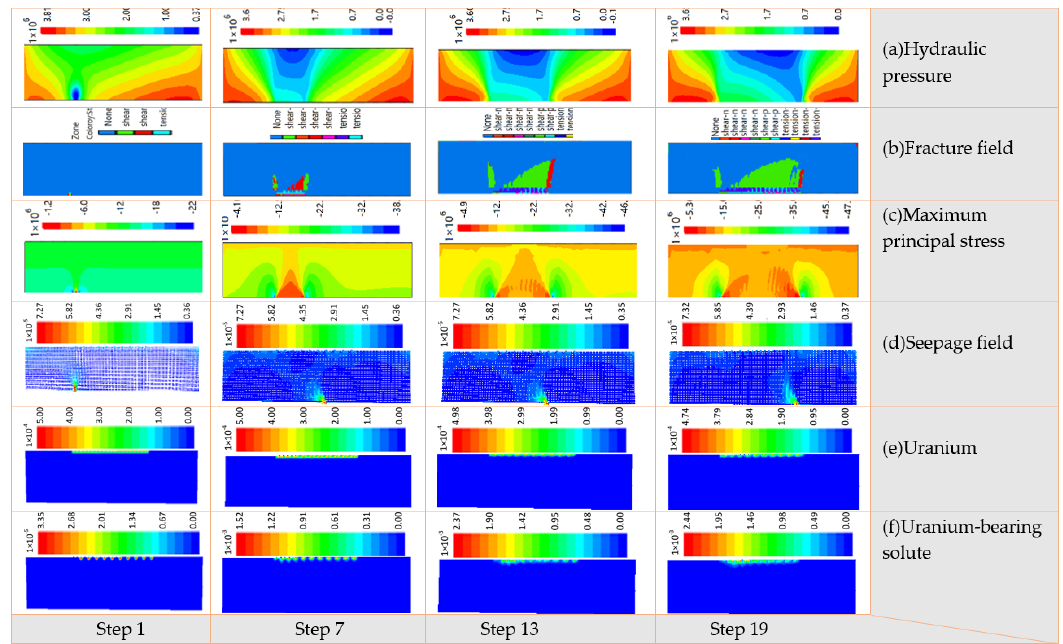
Figure 3. Multifield coupling evolution in the scenario of concurrent coal and uranium mining. ( a ) Hydraulic pressure; ( b ) Fracture field; ( c ) Maximum principal stress; ( d ) Seepage field; ( e ) Uranium, ( f ) Uranium-bearing solute.